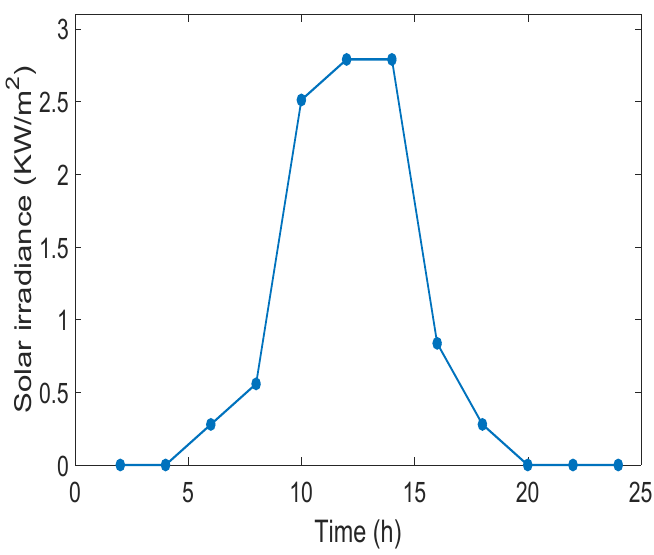
Figure 3. Hourly solar irradiance